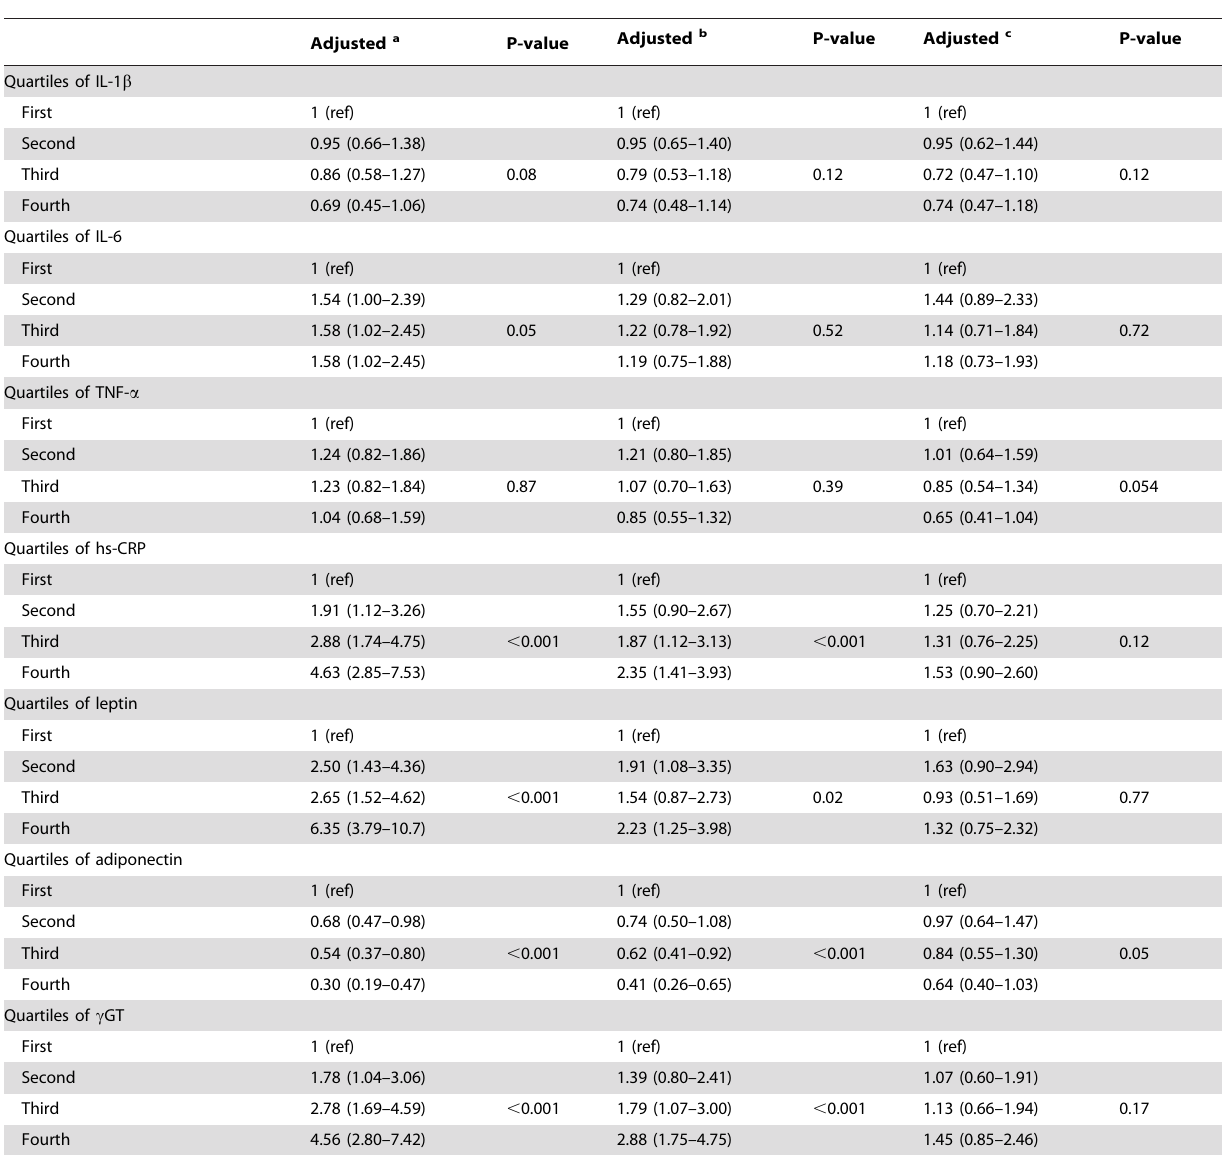
Table 2. Association between adipocytokine, hepatic or inflammatory marker levels and incident type 2